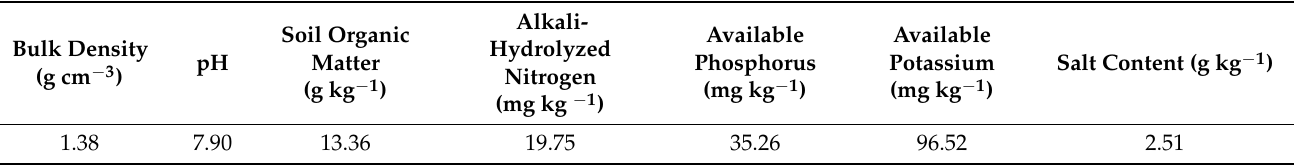
Table 1. Average value of soil property indices of six random soil samples in the plantation of F. velutina